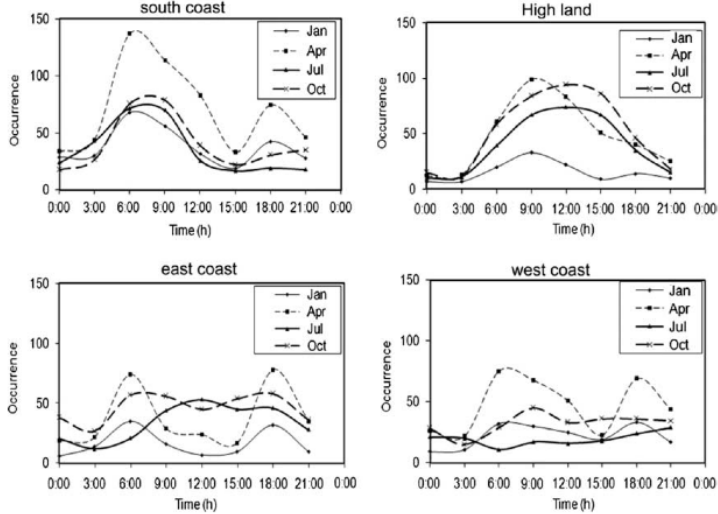
Figure 13. Occurrence of rainfall based on the south coast, high land, east coast and west coast of Peninsular Malaysia (Courtesy: Malaysia Meteorological Department).